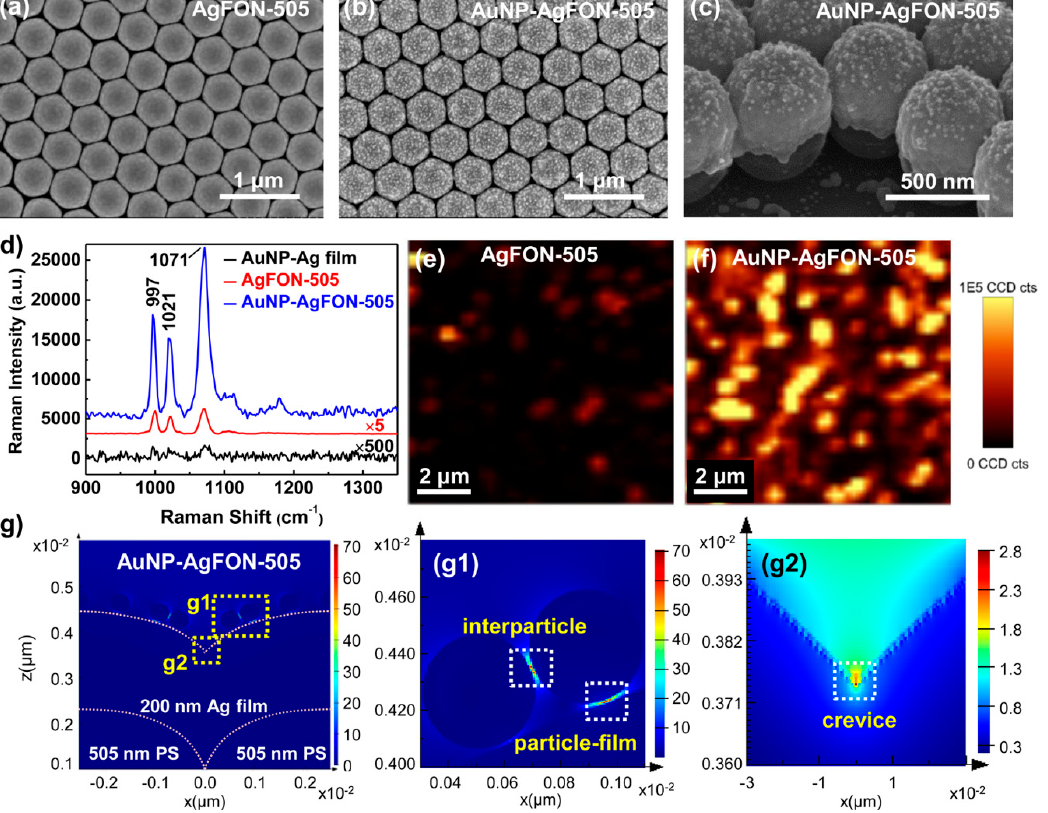
Figure 5. SEM images of AgFON-505 ( a ), AuNP-AgFON-505 ( b ), with cross-sectional image of AuNP-AgFON-505 ( c ). Raman spectra of AuNP-AgFON-505, AgFON-505, and AuNP-Ag film substrates ( d ). Raman mapping images of AuNP-AgFON-505 versus AgFON-505 at 785 nm excitation laser ( e , f ). ( g ) FDTD simulations of E-fields on AuNP assemblies on AgFON-505 substrate at 785 nm laser wavelength. Partially enlarged image for dimer AuNPs ( g1 ) and crevice gap ( g2 ) in AuNP-AgFON-505 system. Reproduced with permission from Reference [78], Copyright 2016, American Chemical Society.